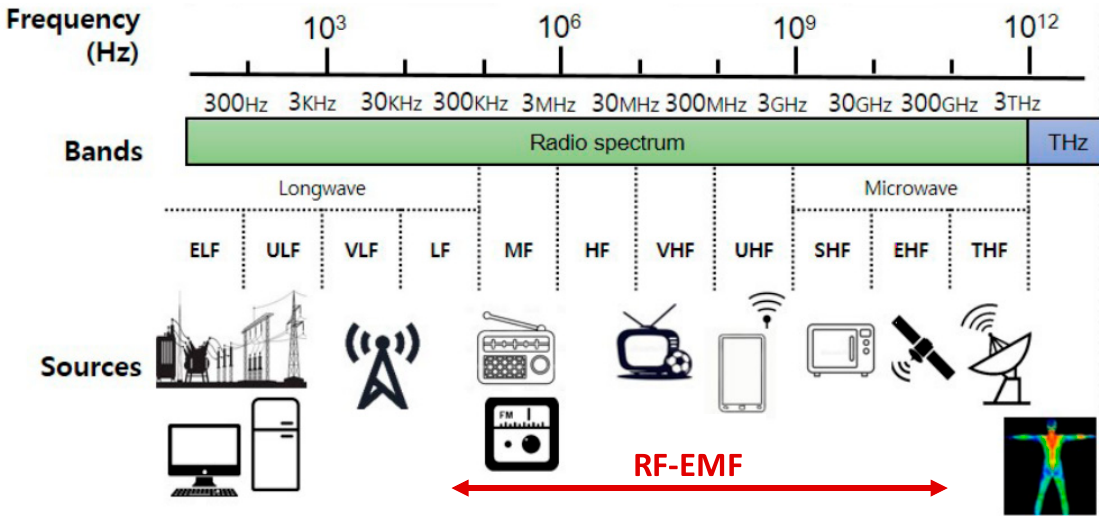
Figure 2. Spectrum of the radiofrequency electromagnetic field (RF-EMF) (30 kHz to 300 GHz) predominantly used for telecommunications applications (adapted from Kim et al. [13]).